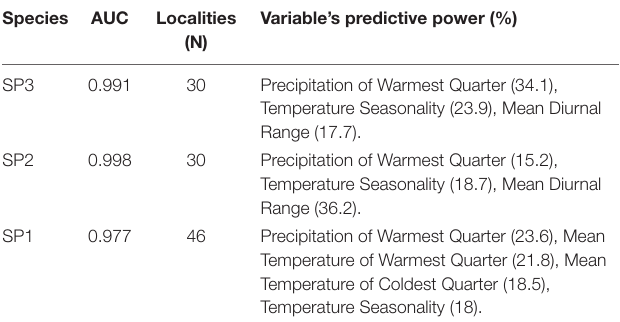
TABLE 5 | AUC localities (N) and highest power bioclimatic variables Species AUC Localities Variable’s predictive power (N)